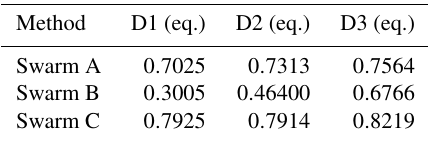
Table 3. Correlation coefficient between the relative number of weighted observations and the F10 . 7